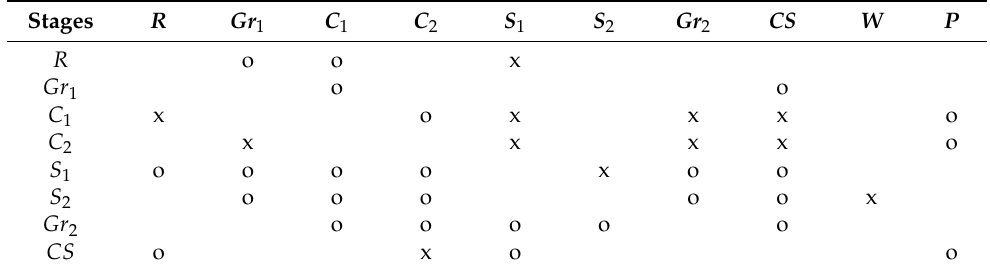
Table 2. Origin–destination matrix for concentrates (o) and tails (x) of flotation system.